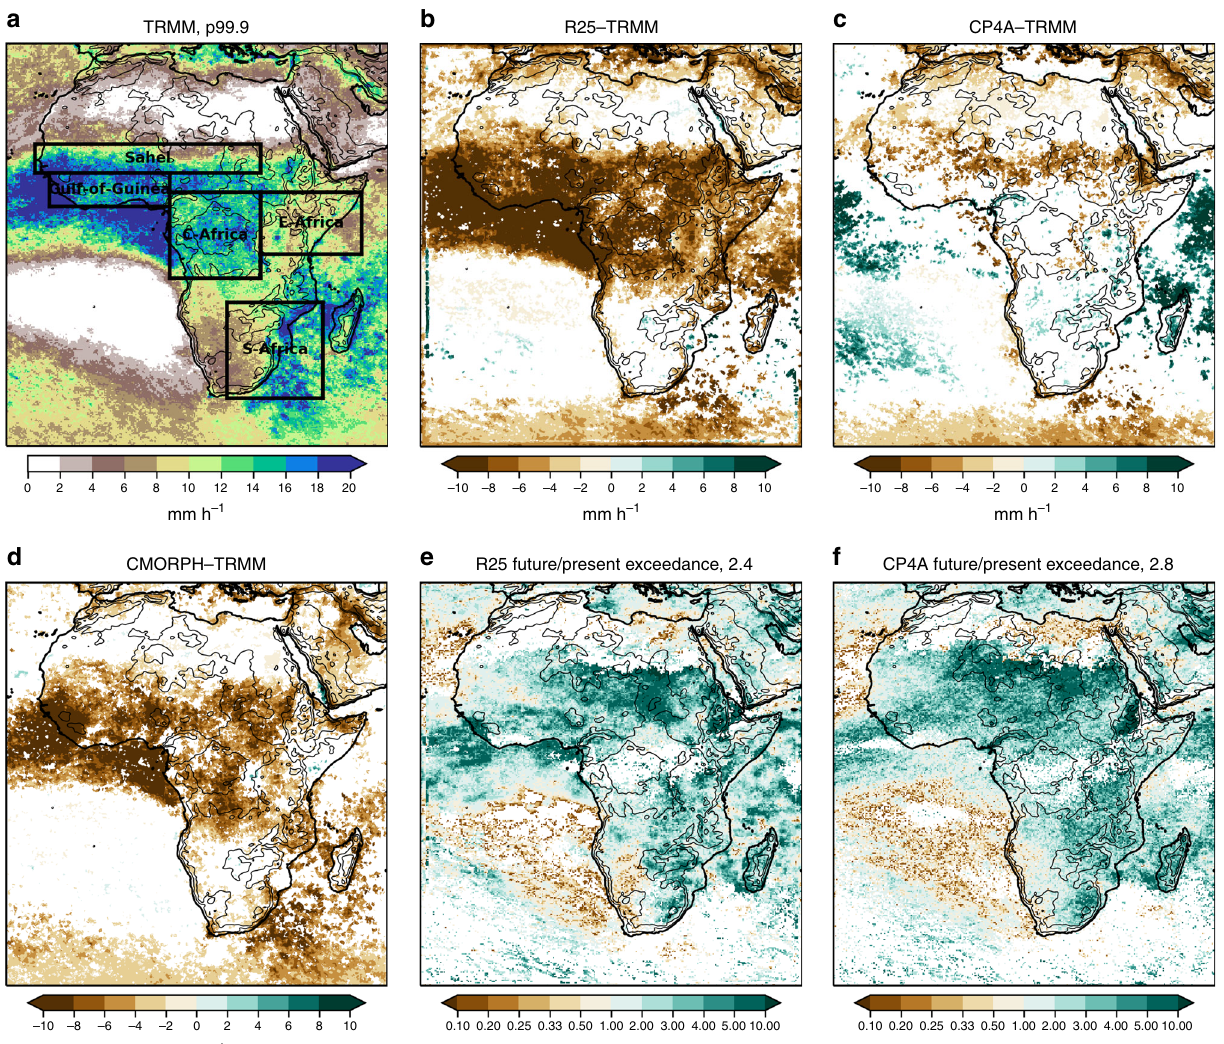
Fig. 6 Present-day extreme precipitation and the frequency of exceedance in future, for the wet season. Present-day extreme precipitation threshold in a TRMM observations, differences with respect to TRMM for b the R25 model, c CP4A model and d CMORPH observations and the ratio of the future compared with the present-day frequency of exceedance of this threshold for e the R25 model and f CP4A model. Extreme precipitation threshold is de fi ned as the 99.9th percentile of 3-hourly precipitation in the wet season in the present-day. The median of future/present exceedance ratio across Africa (land points only) is indicated in e and f . Differences and future changes are masked in white, where differences are not signi fi cant at the 5% level compared with year-to-year variability. For all datasets, the wet season is the 3-month period with the highest mean precipitation in TRMM, de fi ned on a grid-point basis. The black lines indicate the 500 -, 1000 -, 2000-, 3000 - and 4000 -m height contours. De fi nition of Africa sub-regions for subsequent analysis is shown in